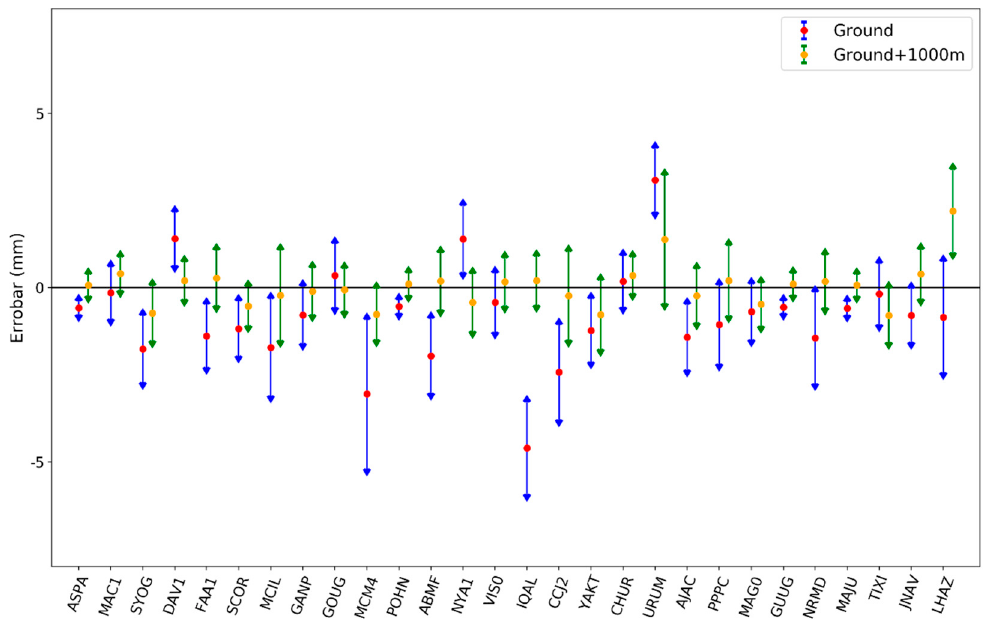
Figure 3. Mean biases and standard deviations between Saastamoinen derived zenith hydrostatic delay (ZHD) estimates and radiosonde ZHD estimates for the 28 stations of this study. The radiosonde ZHD estimates were computed either from the ground (blue arrows) or from ground + 1000 m (green arrows).